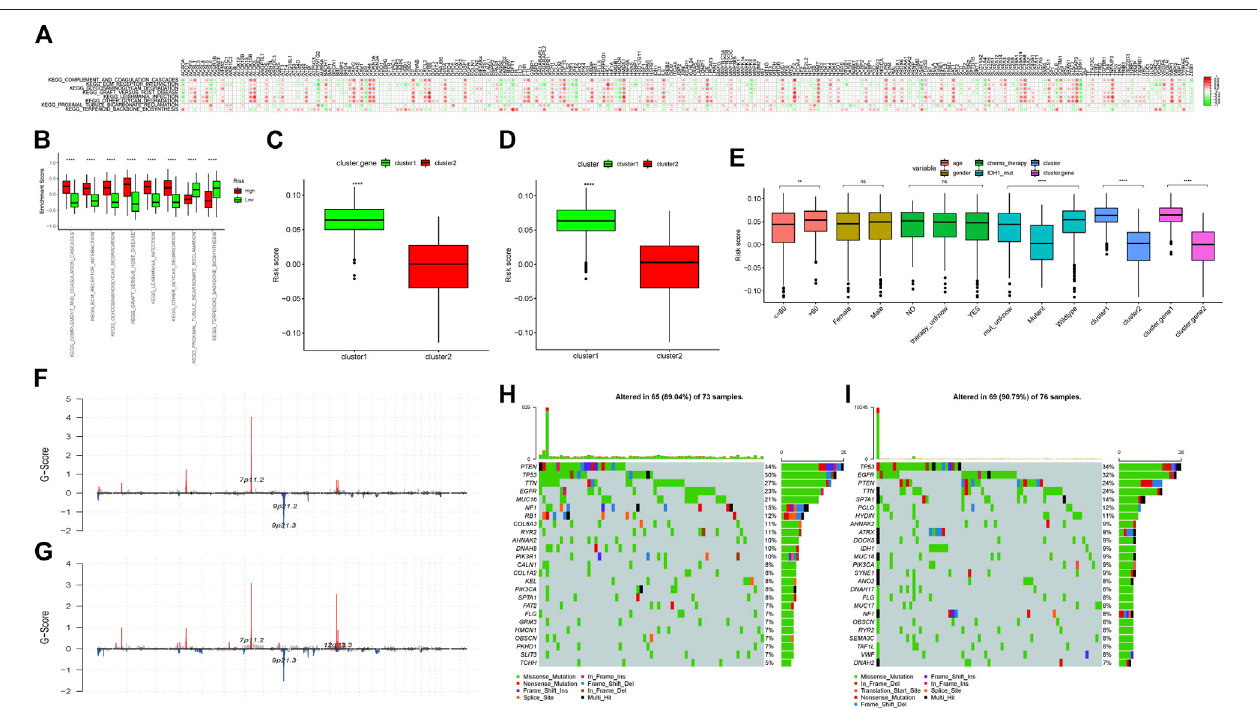
FIGURE 5 | (A) Correlation analyses between ferroptosis-related genes and differential enrichment pathway scores. The abscissa axis represents the names of ferroptosis-relatedgenes;theordinateaxisrepresentsdifferentialenrichmentpathways. ThelegendontherightrepresentsdifferentPearsoncorrelationcoef fi cients. (B) Difference in the enrichment scores of the subgroups with high- and low-risk scores. The abscissa axis represents pathways with different enrichment scores; the ordinate axis represents enrichment scores. Red represents the high-score group; green represents the low-score group. ppppp means p < 0.0001; ppp means p < 0.001; pp means p < 0.01; and p means p < 0.05. (C) Risk score difference analysis between the two “ Ferroptosis.gene.cluster ” . The abscissa axis represents different clusters;theordinateaxisrepresentsriskscore. pppp means p < 0.0001; ppp means p < 0.001; pp means p < 0.01;and p means p < 0.05. (D) Riskscoredifferenceanalysis between ferroptosis clusters. The abscissa axis represents different ferroptosis clusters; the ordinate axis represents different risk scores. pppp means p < 0.0001; ppp means p < 0.001; pp means p < 0.01; and p means p < 0.05. (E) Risk score difference analysis for different clinical characteristics and different molecular types. The abscissa axis represents different clinical features and molecular types; the ordinate axis represents different risk scores. pppp means p < 0.0001; ppp means p < 0.001; pp means p < 0.01; and p means p < 0.05. (F) DifferenceofCNV sites inthe high-riskscoregroup. Theabscissa axisrepresentsthe location ofCNV on thechromosome; the ordinate axis represents G-score. (G) Difference ofCNV sites in the low-risk score group. The abscissa axis representsthe location ofCNV on the chromosome; the ordinate axis represents G-score. (H) Mutations in the high-risk score group. The left column represents the name of the mutant genes; the right column represents the percentageofgeneswithmutations; different colorsrepresent different mutationtypes. (I) Mutations inthelow-riskscoregroup. Theleft columnrepresentsthenameof the mutant genes; the right column represents the percentage of genes with mutations; different colors represent different mutation